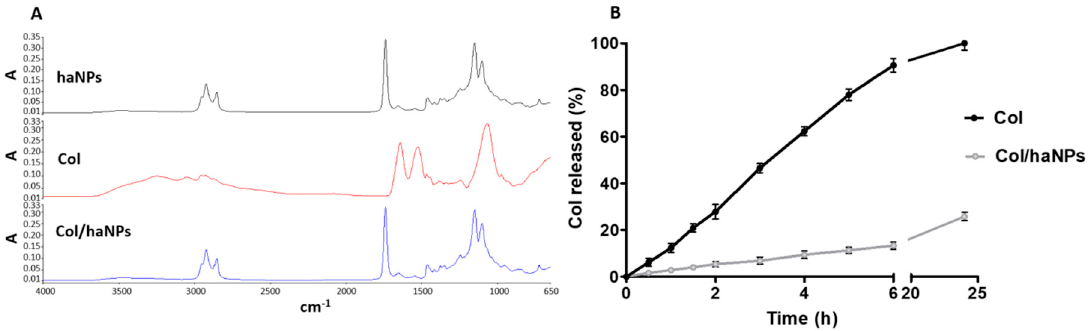
Figure 1. ( A ) FTIR spectra of blank haNPs, Col and Col/haNPs. ( B ) In vitro release kinetics of Col from Col/haNPs.